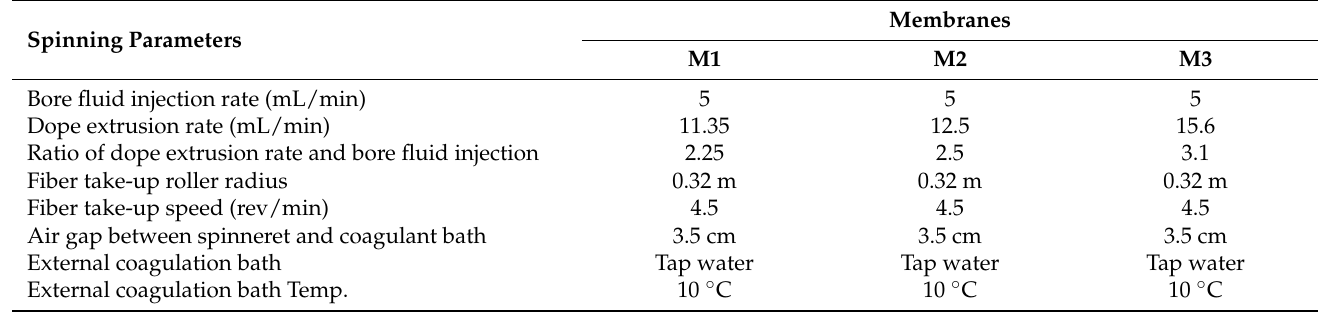
Table 1. Spinning conditions of hollow fiber